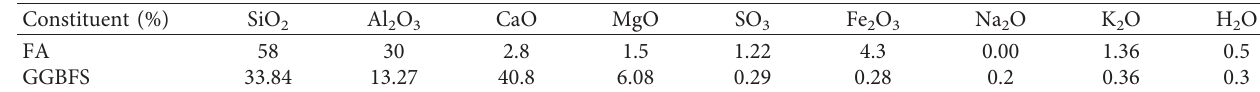
Figure 1: Gradation curves of different Table 1: Chemical compositions of FA and GGBFS.